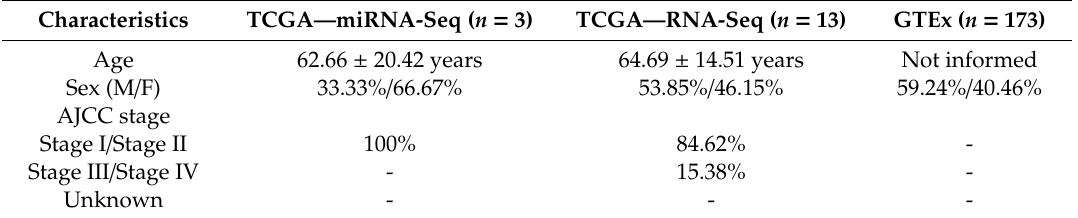
Figure 3. Data mining workflow. The GTEx data were downloaded using the recount v.1.14.0 package. The TCGA data were downloaded using the TCGAbiolinks v.2.16.1 package. The di ff erential analyses were performed using the DESeq2 package. Transcripts with FDR adjusted p -value < 0.05 and |Log 2 (Fold-Change)| > 2 were considered statistically significant. TUM = Primary Tumor. SNT = Solid Normal Tissue. The red box indicates the filters applied during casuistic selection. Table 2. Clinical characteristics of patients selected from the GTEx and TCGA dataset.